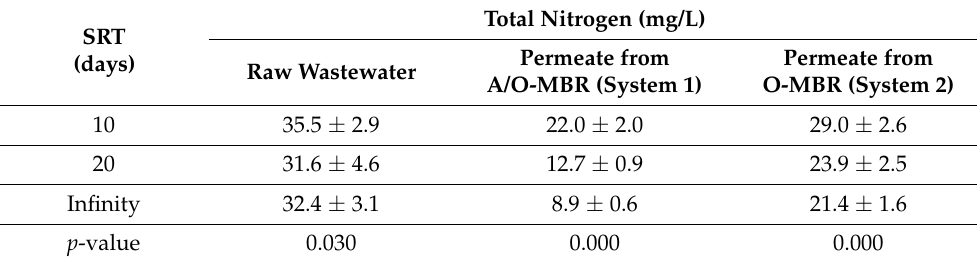
Table 3. Efficiencies of the A/O-MBR and O-MBR systems on total nitrogen